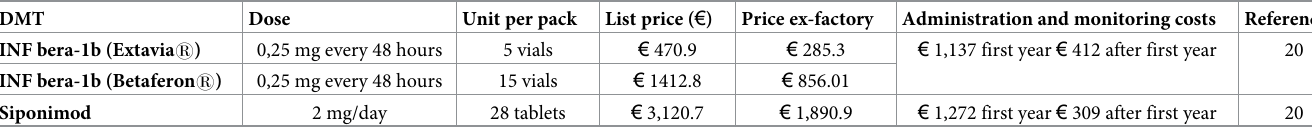
Table 3. Disease-modifying therapies (DMTs) costs.